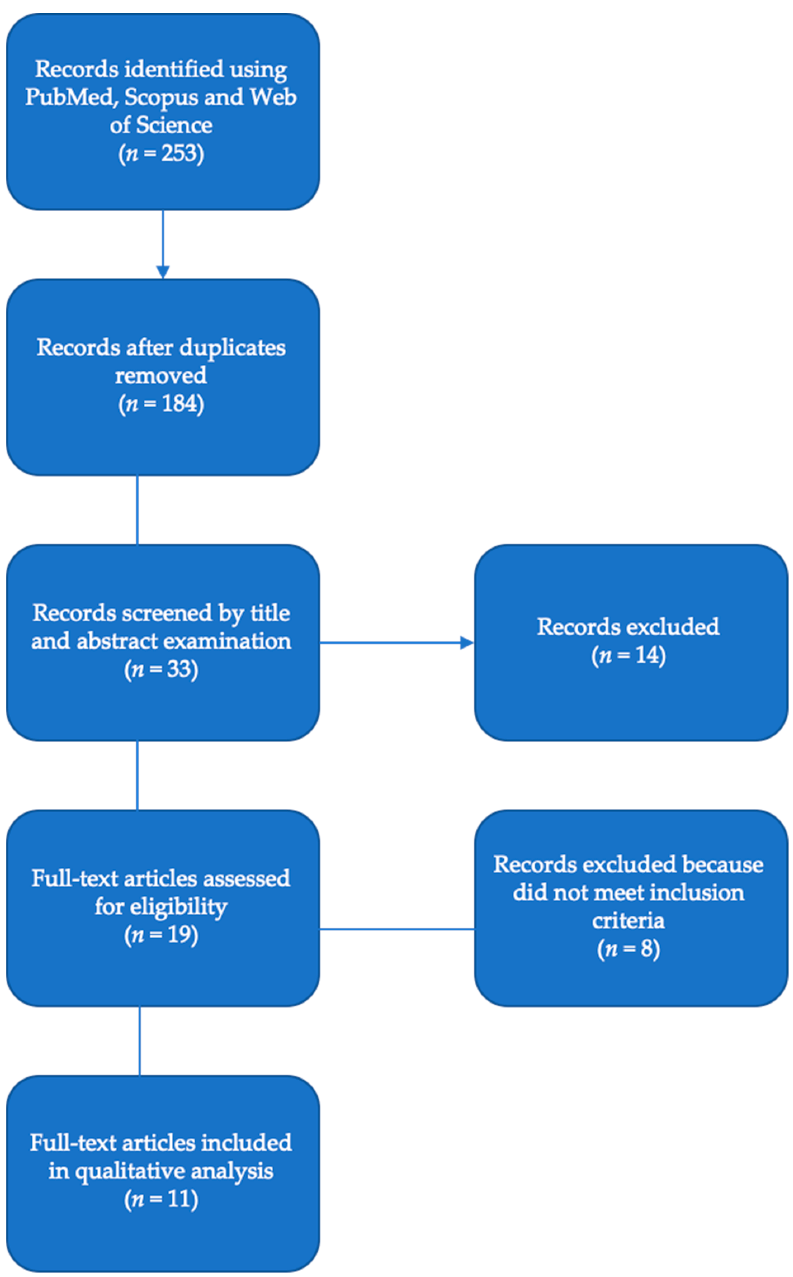
Figure 1. Flow chart according to PRISMA statement.